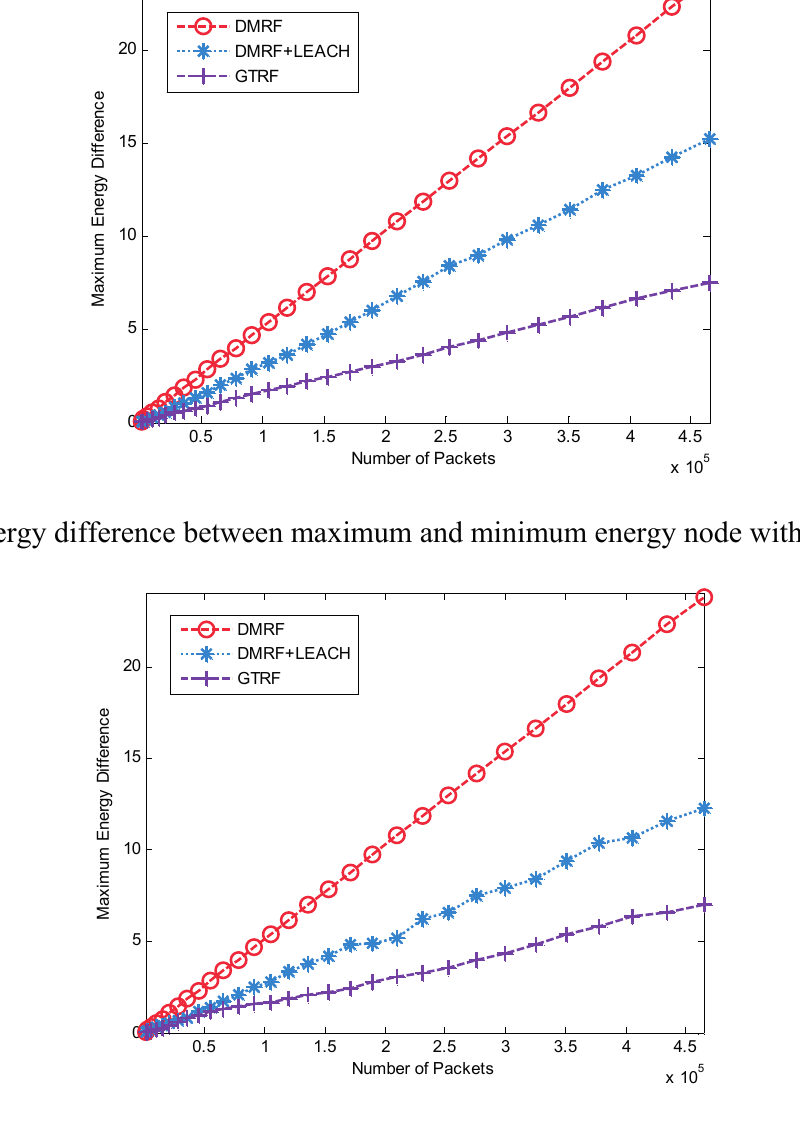
Figure 9. Energy difference between maximum and minimum energy node without selfish